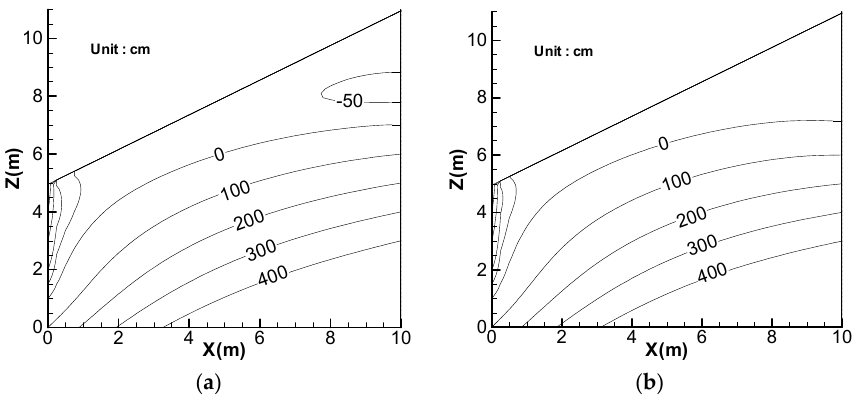
Figure 11. Pressure head contours for duration of 48 h with uniform rainfall of 400 mm at time: ( a ) 40 h; and ( b ) 48 h.